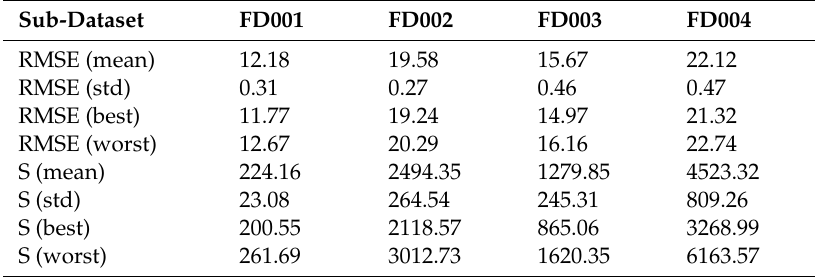
Table 5. The performance of the model (std: standard